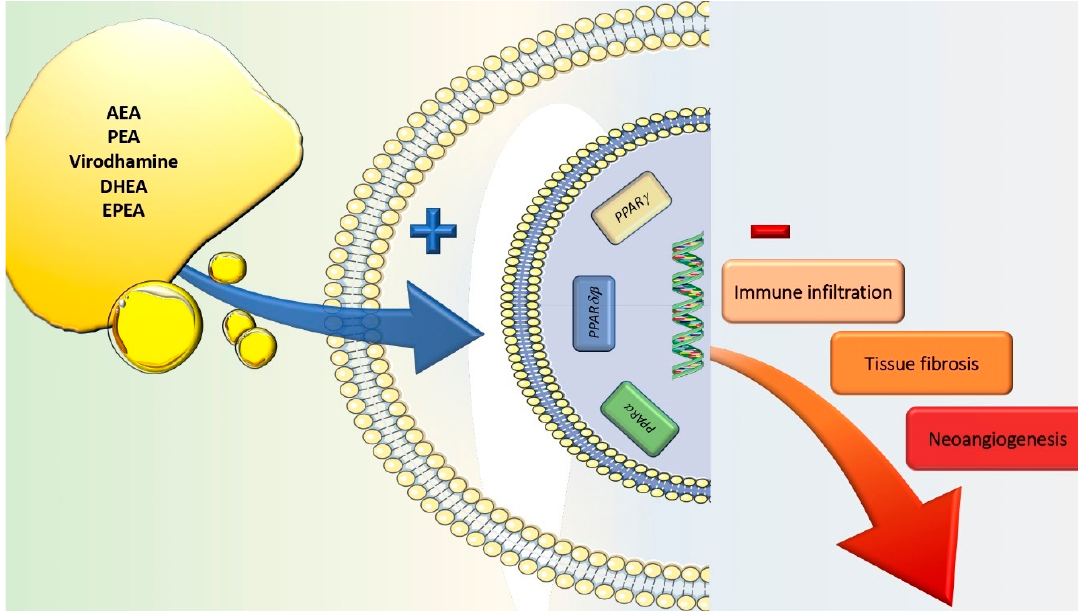
Figure 2. Agonism on peroxisome proliferator-activated receptor (PPAR) family members, mediated by a wide array of molecules (i.e., AEA, palmitoylethanolamide (PEA), virodhamine, DHEA and EPEA), negatively interferes with corneal tissue immune infiltration, fibrosis and neovascularization.